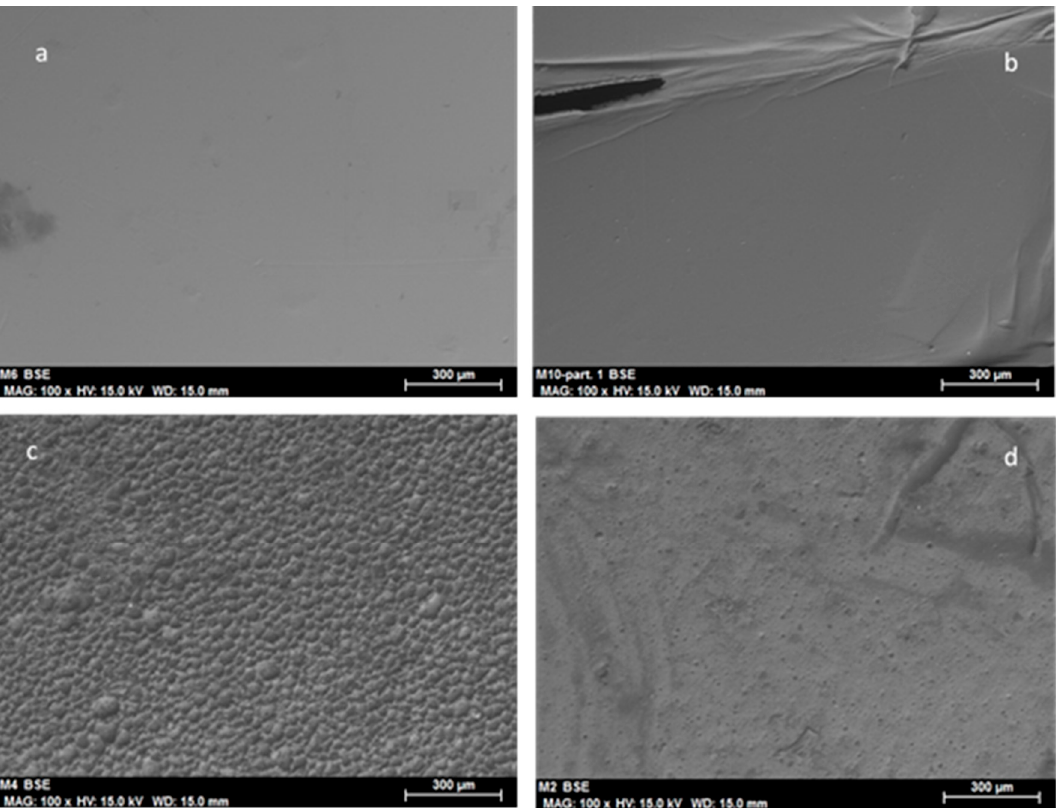
Figure 12. Scanning electron micrographs of the sample prepared with PVC and ionic liquids [Omim] [NTf 2 ] in the absence of enzyme: ( a ) whole fresh sample (100×) (scale bar = 300 μ m), ( b ) crushed fresh sample (100×) (scale bar = 300 μ m), ( c ) crushed sample after 1 cycle (100×) (scale bar = 300 μ m), and ( d ) crushed sample after 5 cycles (100×) (scale bar = 300 μ m).